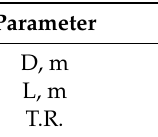
Figure 1. Schematic diagram of the inlet model. Table 1. Geometrical configuration data of the inlet.